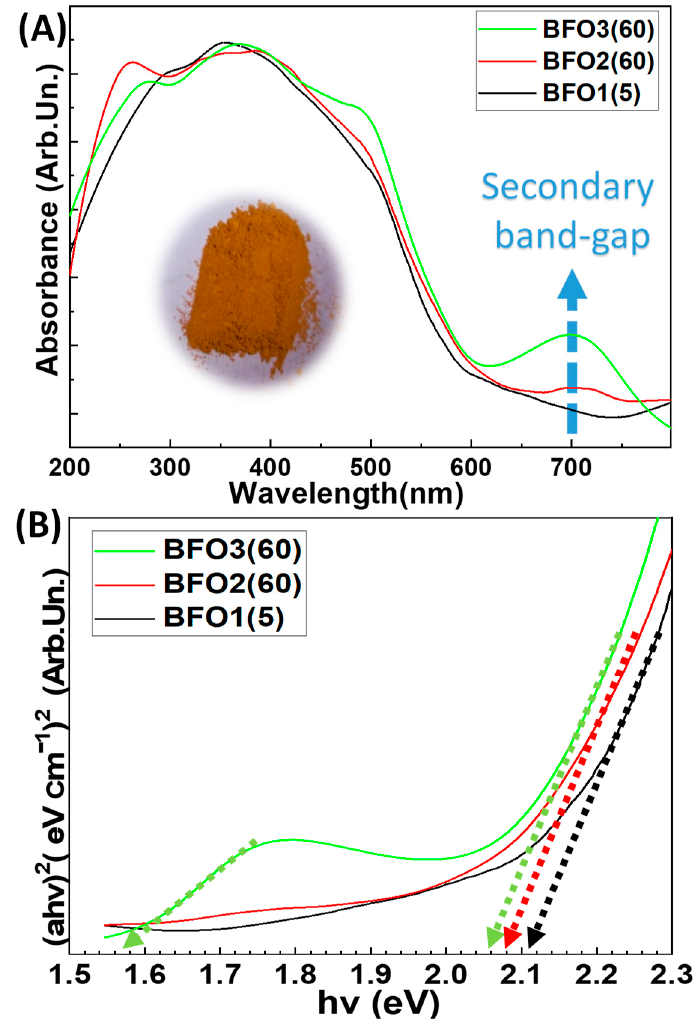
Figure 2. ( A ) DRS-UV/Vis spectra of the BFO materials. Inset : the BFO3(60) powder color. ( B ) The Tauc plot for each material, with the tangential dashed lines marking the estimated band-gap.